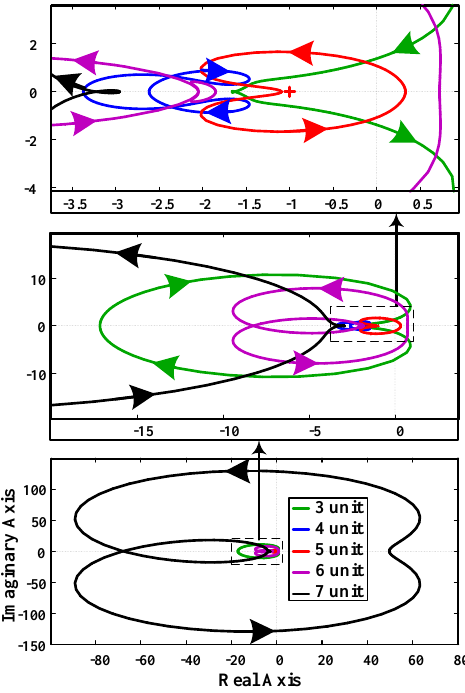
Figure 10. Nyquist plot for different sizes of active